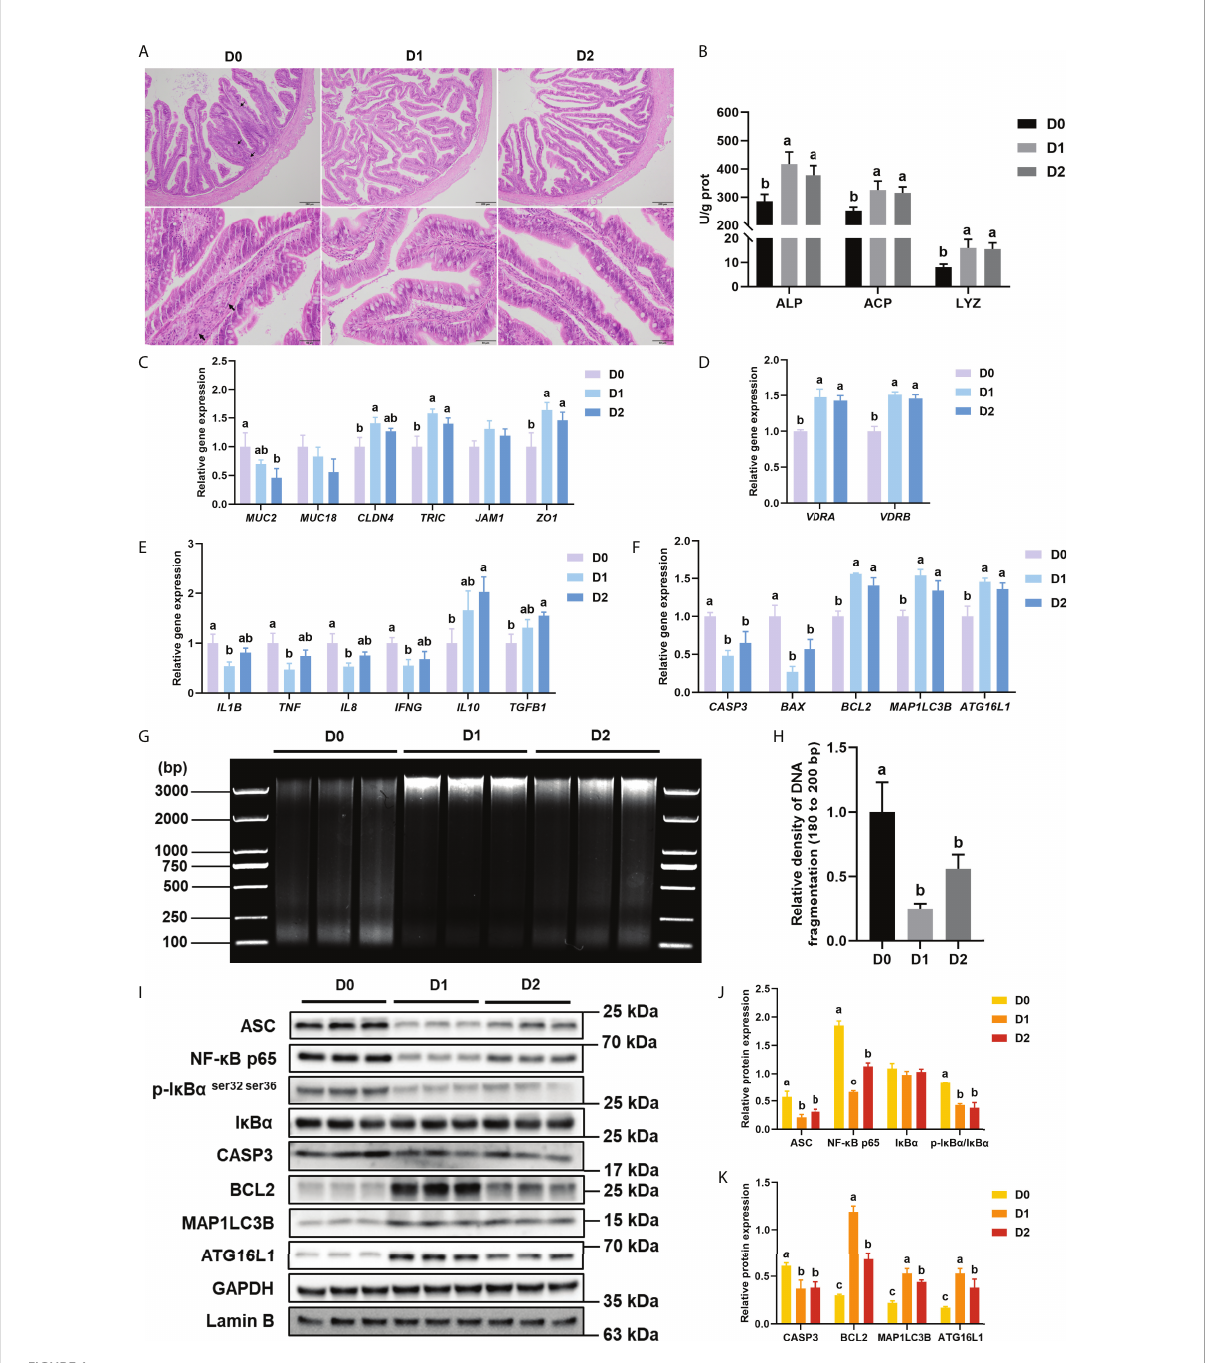
FIGURE 1 In fl ammation, apoptosis, and autophagy of intestine with VD 3 treatments in vivo . (A) H&E staining of intestine (Black bars, 200 m m or 50 m m), Black arrows indicate widening of the intestinal lamina propria. (B) Alkaline phosphatase, acid phosphatase activities, and lysozyme activities. (C) The relative mRNA expression level of MUC2 , MUC18 , CLDN4 , TRIC , JAM1 , and ZO1 . (D) The relative mRNA expression level of VDRA&B . (E) The mRNA expression levels of IL1B , TNF , IL8 , IFNG , TGFB1 , and IL10 . (F) The mRNA expression levels of CASP3 , BCL2 , BAX , MAP1LC3B , and ATG16L1 . (G, H) DNA fragmentation and quanti fi cation of the density of the 180 to 200 bp DNA band. (I-K) The level of ASC, intranuclear NF- k B p65, total I k B and phosphorylated I k B, CASP3, BCL2, MAP1LC3B, and ATG16L1 were analyzed and quantitated by western blot. The blots of ASC, I k B a , p- I k B a ser32 ser36 , CASP3, BCL2, MAP1LC3B, and ATG16L1 were used for GAPDH loading control, while the blot of NF- k B p65 was used for Lamin B loading control. Error bars of columns denote SD (n = 3), and columns with different letters above them are signi fi cantly different ( P <